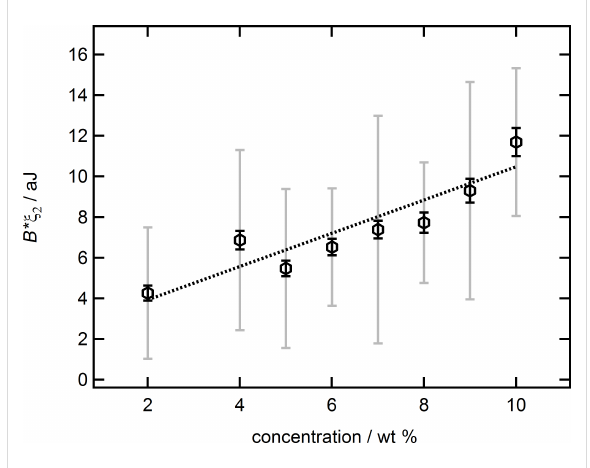
Figure 11: B · ξ 2 in aJ as a function of the suspension concentration in wt % together with a linear trend. Two different errors are given, one based on the width of last iteration step (solid black bars) and the other on one standard deviation of free parameters from the first analysis with extended fit equation (grey solid bars), see Figure